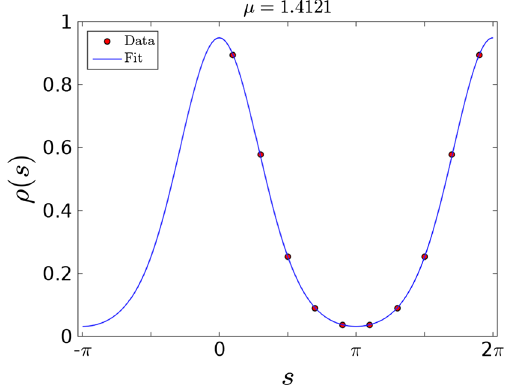
Fig. 2 Same as Fig. 2 but with the density close to offset, again the sign problem is weak